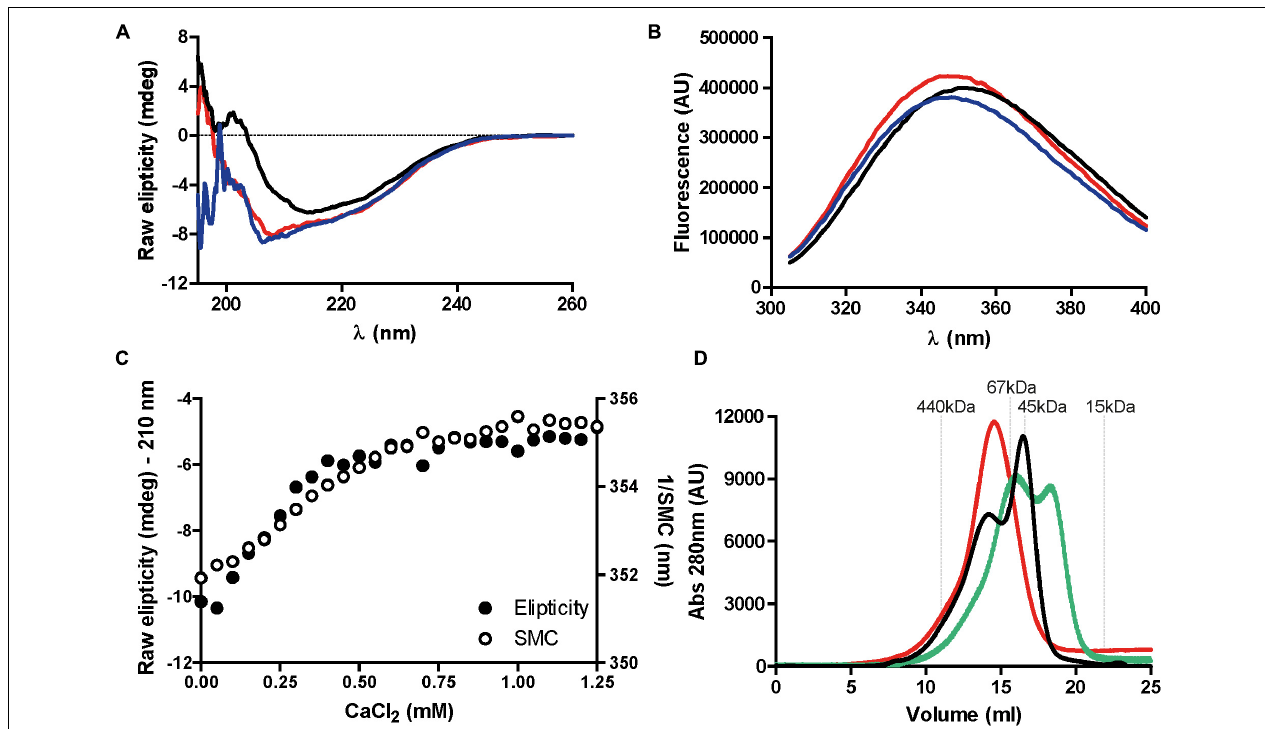
FIGURE 5 | Effect of calcium on RapD structure. (A) Circular dichroism spectra of purified recombinant decalcified RapD (Apo-RapD) (3.75 µ M) in the absence of calcium (red line), 1.25 mM calcium (black line), or 1.25 mM calcium supplemented with EGTA 3 mM (blue line). (B) Fluorescence spectroscopy of RapD (3.75 µ M) in response to calcium. Apo-RapD fluorescence in the absence of calcium (red line), with 1.25 mM calcium (black line) and with 1.25 mM calcium supplemented with 3 mM EGTA (blue line) is indicated. (C) Raw ellipticity measured at 210 nm and spectral mass center (SMC) of Apo-RapD in response to increasing calcium concentrations (0–1.25 mM) showing simultaneity for secondary structure changes and marginal exposure of the single tryptophan. (D) Hydrodynamic changes of RapD (1 mg/ml) in response to calcium. Size exclusion chromatography of recombinant RapD in absence of calcium (red line), 0.75 mM CaCl 2 (green line) or, 1.25 mM CaCl 2 (black line). Molecular weight markers used for calibration are